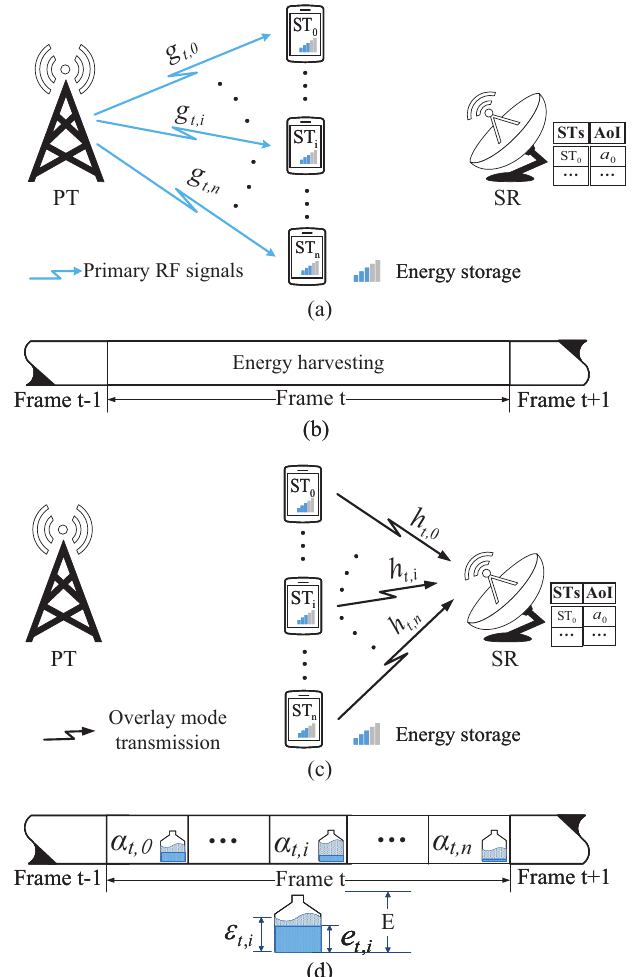
Figure 3. System model and frame structure of the CRNs: ( a ) depicts the system model when = 1. ( b ) depicts the time frame structure when s a s a t ( d ) depicts the time frame structure when s a